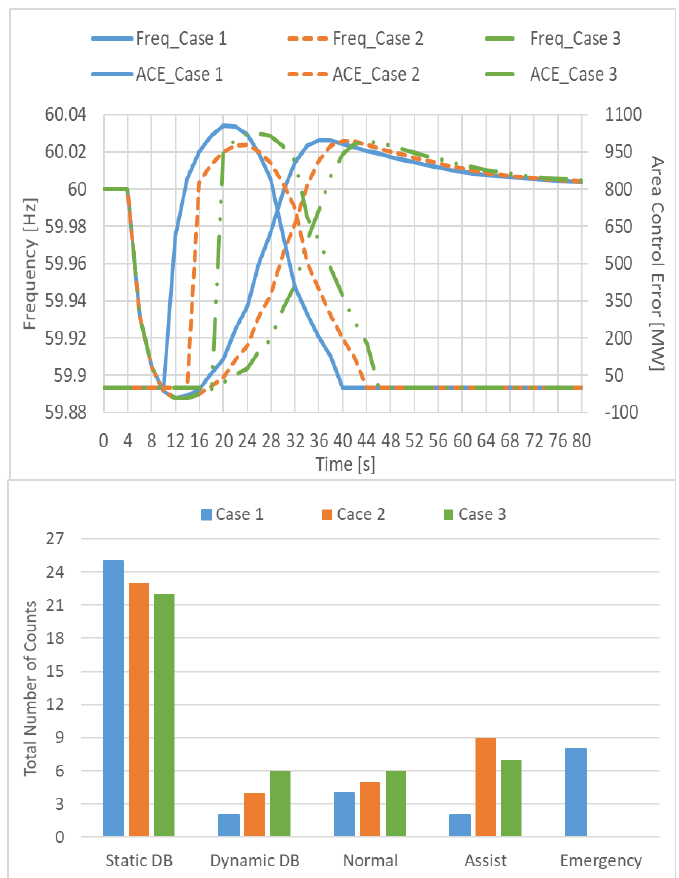
Figure 19. Comparison of frequency response with different bounds of control mode ( upper ) and the distribution of the determined control mode ( lower ).